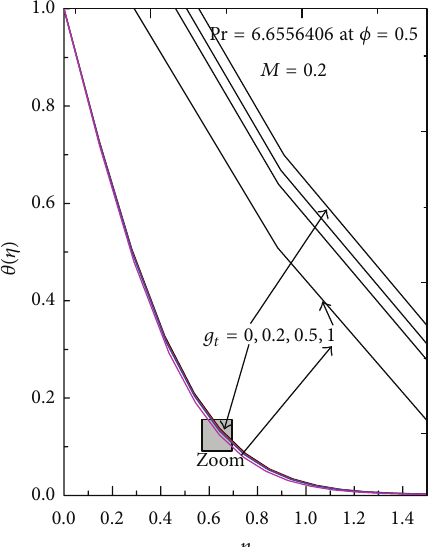
Figure 9: Effect of temperature buoyancy parameter on tempera-